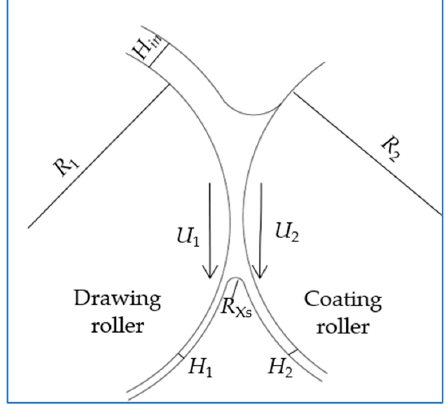
Figure 4. Simplified model of the roll coating.